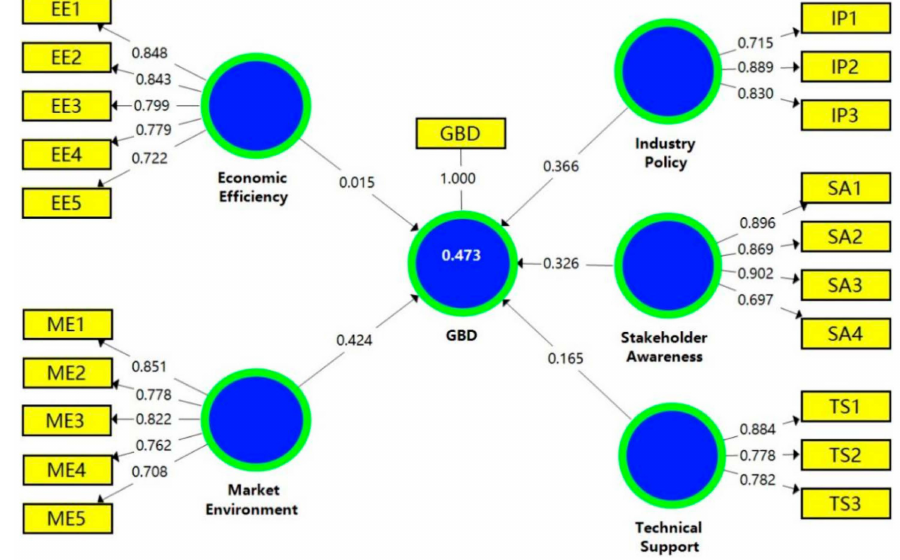
Figure 2. Assessment results of path coe ffi